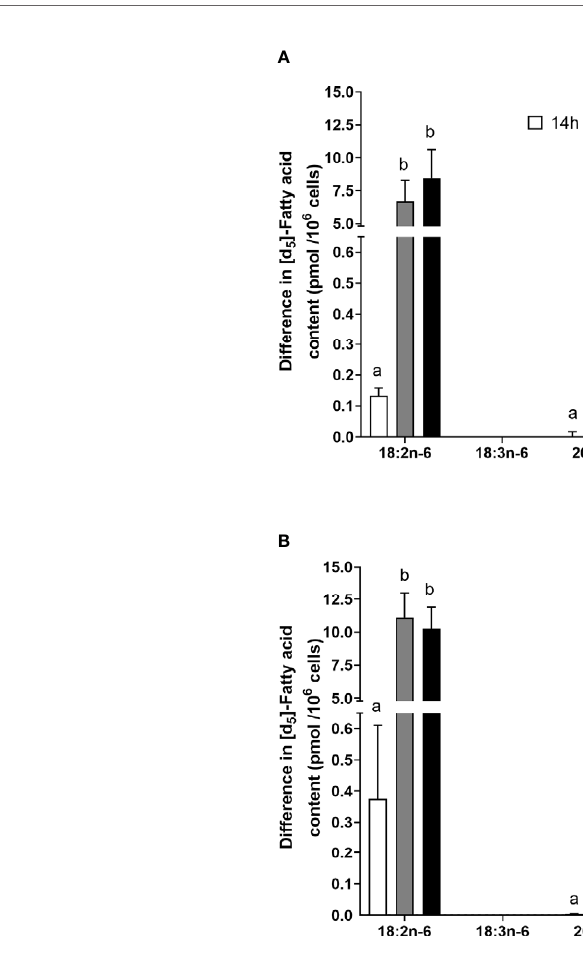
Two-way ANOVA EFA